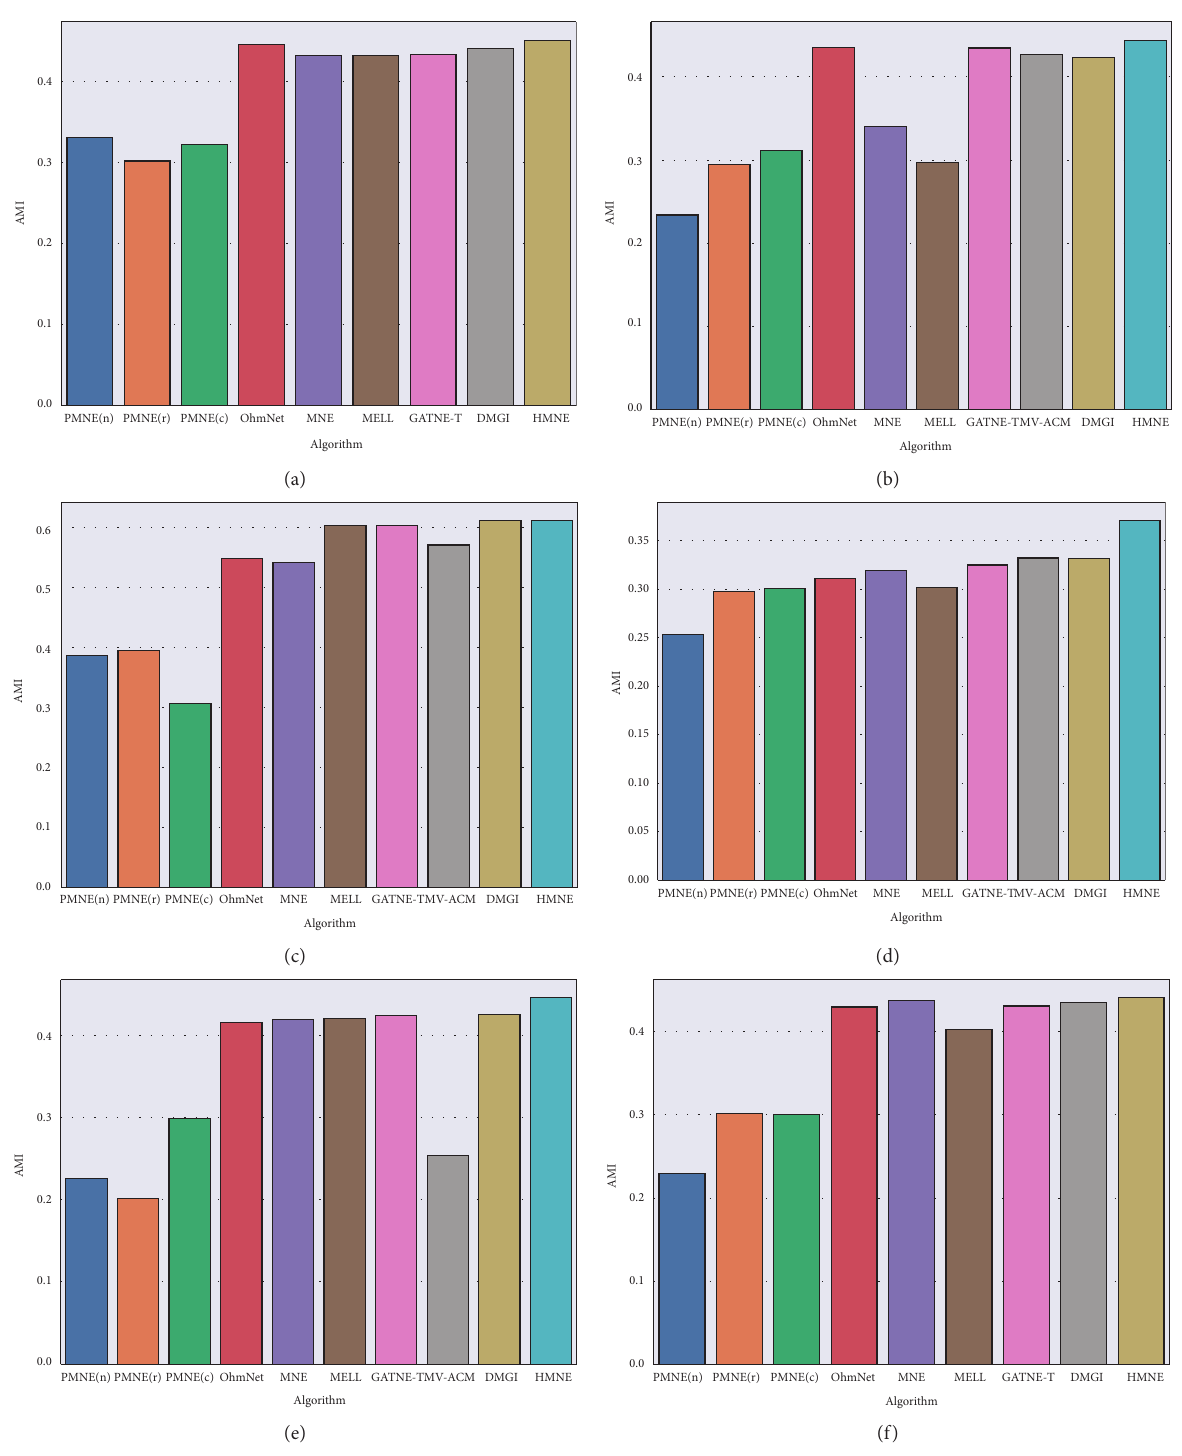
Figure 3: The AMI scores of HMNE in real-world multiplex networks. For the cross-domain link prediction task, AMI is regarded as an indicator to evaluate the embedding performance. (a) Celegans. (b) CKM. (c) CS-Aarhus. (d) London. (e) Vickers. (f)